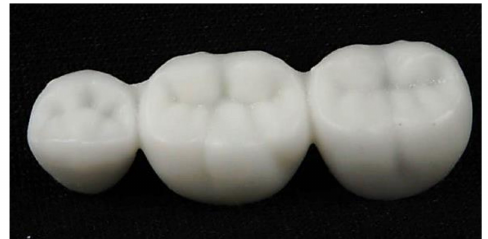
Figure 7. 3D printed provisional